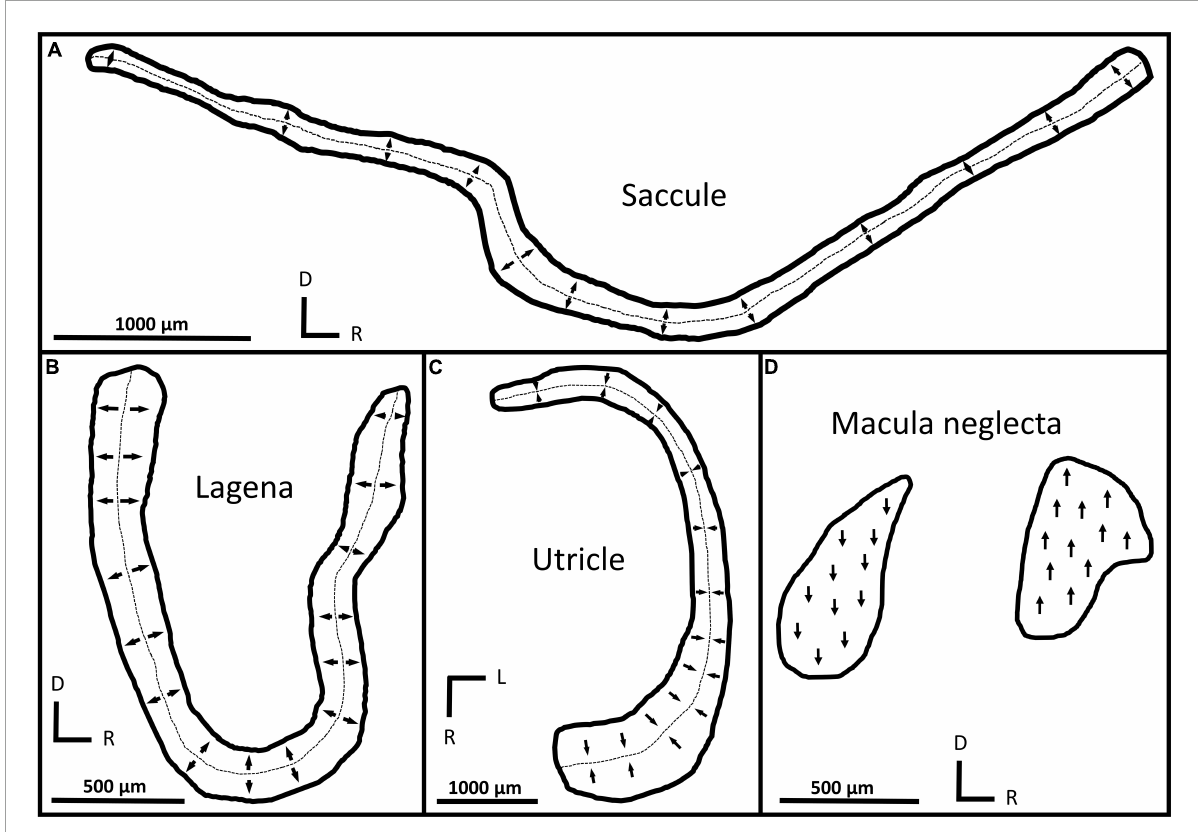
FIGURE5 Tracings of macula shapes and orientation groups in the saccule (A) , lagena (B) , utricle (C) , and macula neglecta (D) from C. isabellum . Arrows indicate the orientation of hair cells within different locations of the maculae and the dotted lines mark the approximate boundary between orientation groups. D , dorsal; R , rostral; L ,